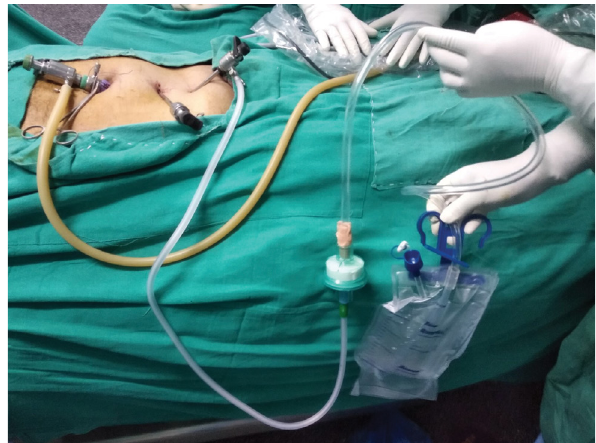
Figure 2: Trocar was connected with a tube to a HME filter which was again connected to an underwater seal bag filled with 5 % Sodium Hypochlorite solution.